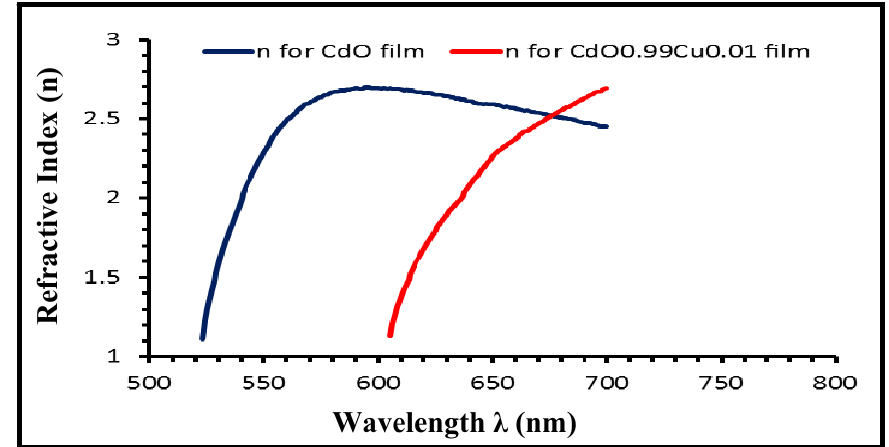
Fig.8: Refractive index as a function of wavelength of CdO and CdO